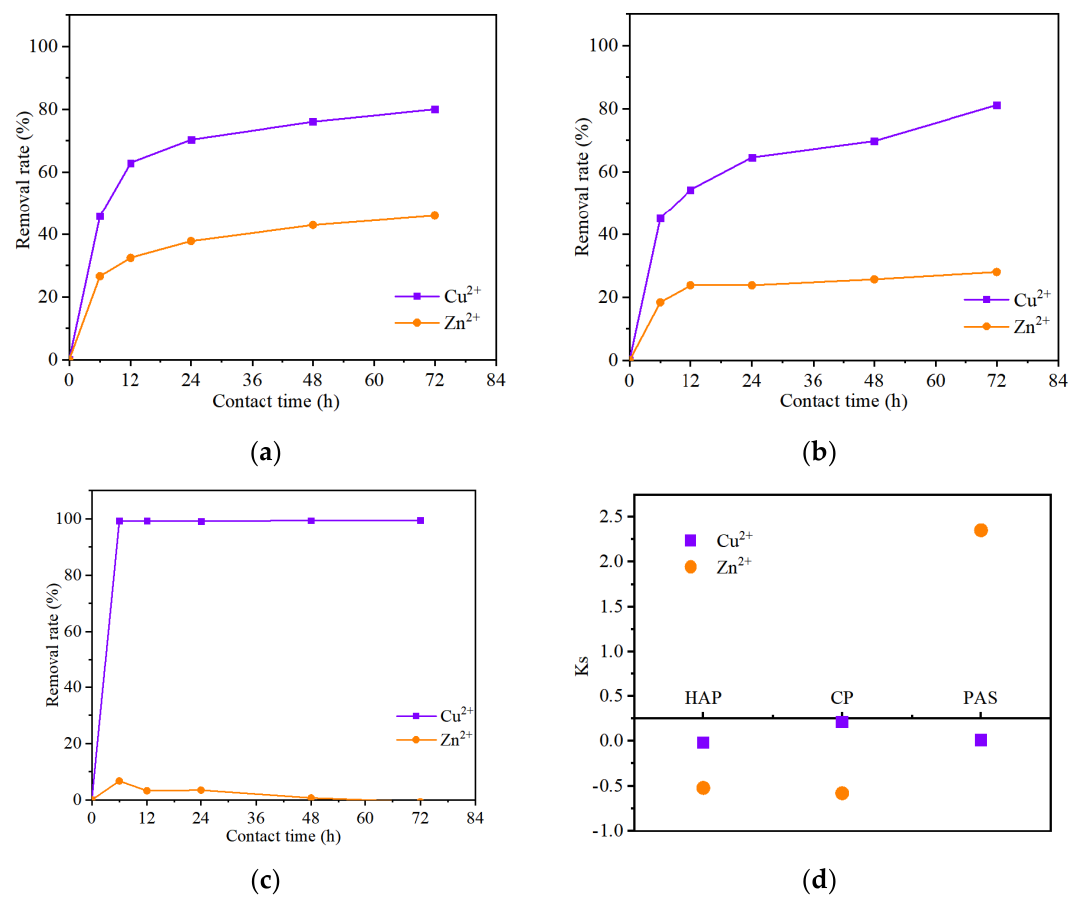
Figure 4 . The selective adsorption of Cu 2+ and Zn 2+ on HAP ( a ), CP ( b ), PAS ( c ); the distribution of selectivity coefficient ( d ).